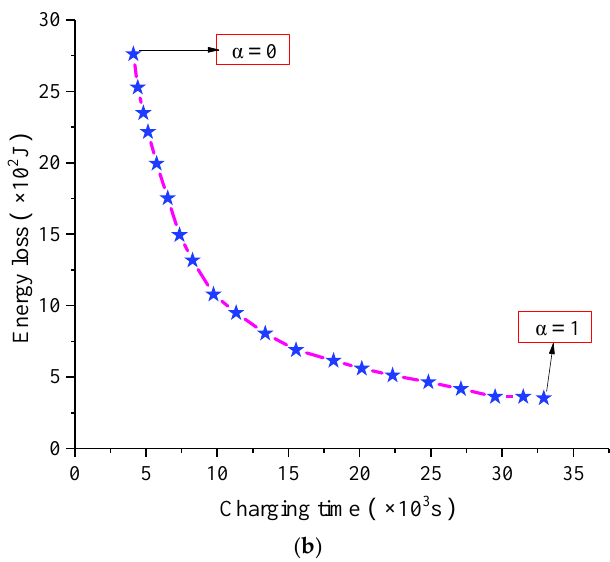
Figure 9. Comparison between charging current curves for different weights and charging time and energy loss for different weights. ( a ) Charging current curve; ( b ) Charging time and energy loss.